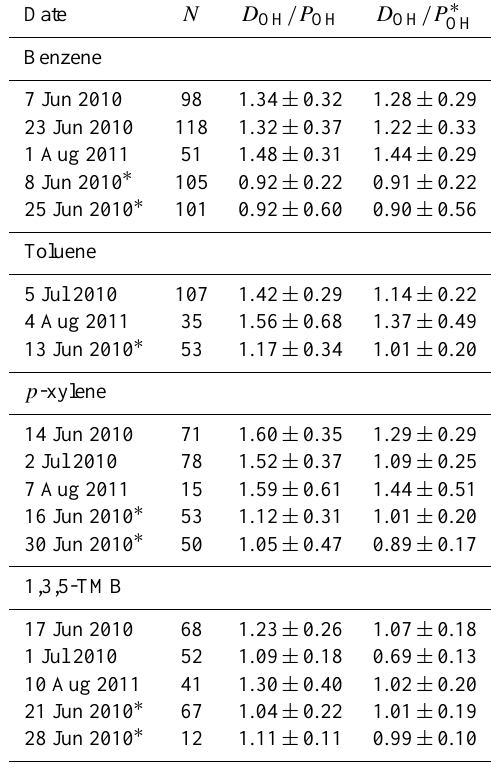
Table 3. Analysis of OH budgets during SAPHIR experiments. Means and standard deviations of the ratios D OH /P OH and D OH /P ∗ calculated from measurements according to Eqs. (2) and OH (5), respectively. The data evaluation was restricted to time periods where the chamber was illuminated and aromatic OH reactants were present. N denotes the number of data